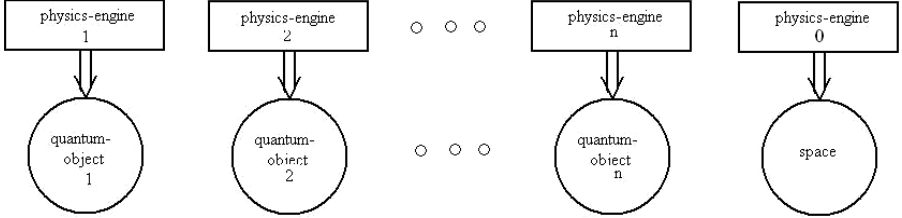
Fig. 1. Physics engines assigned to quantum objects and to